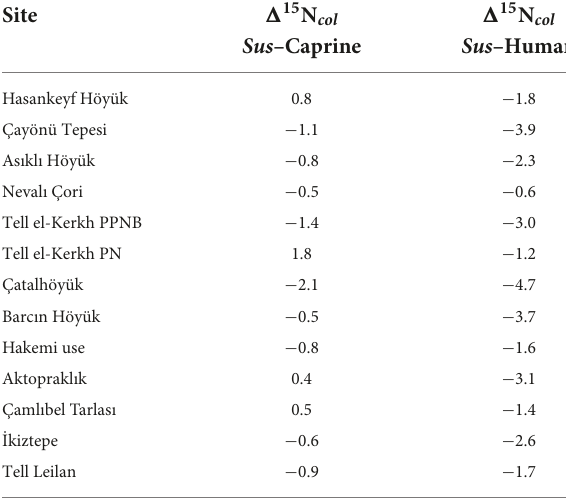
TABLE 4 Differences in the nitrogen isotopic compositions of bone collagen ( (cid:49) 15 N col ) between Sus scrofa and Caprine and between Sus scrofa and humans at prehistoric sites in the Near